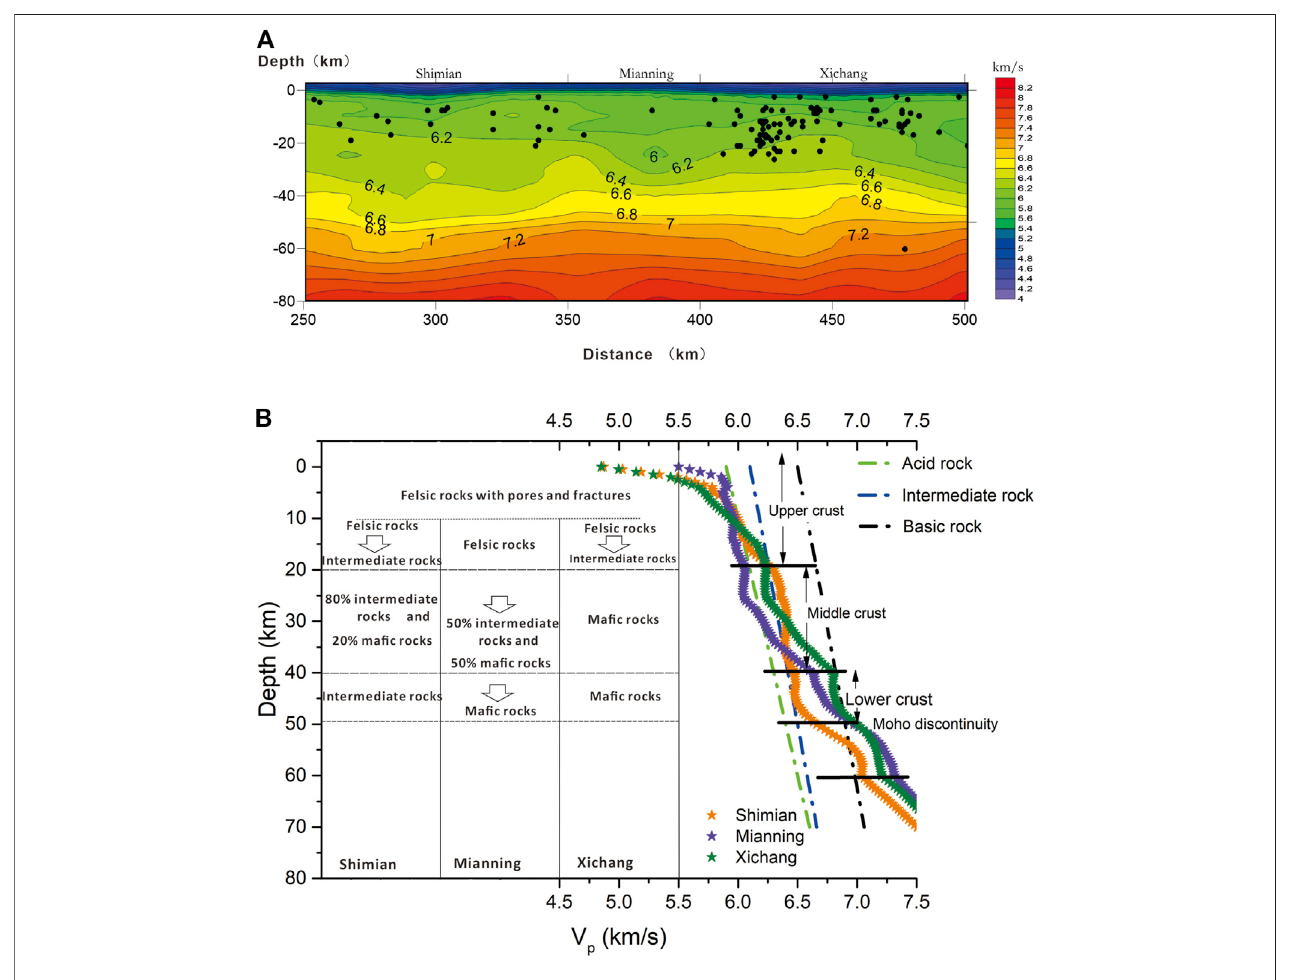
FIGURE 5 | (A) Deep-imaging seismic data along the Anninghe fault. Black small circles show hypocenters of earlier documented historical earthquakes (2008 – 2021). (B) Comparison between the experimental data and the deep-imaging seismic data shown alongside the crustal rock composition model.